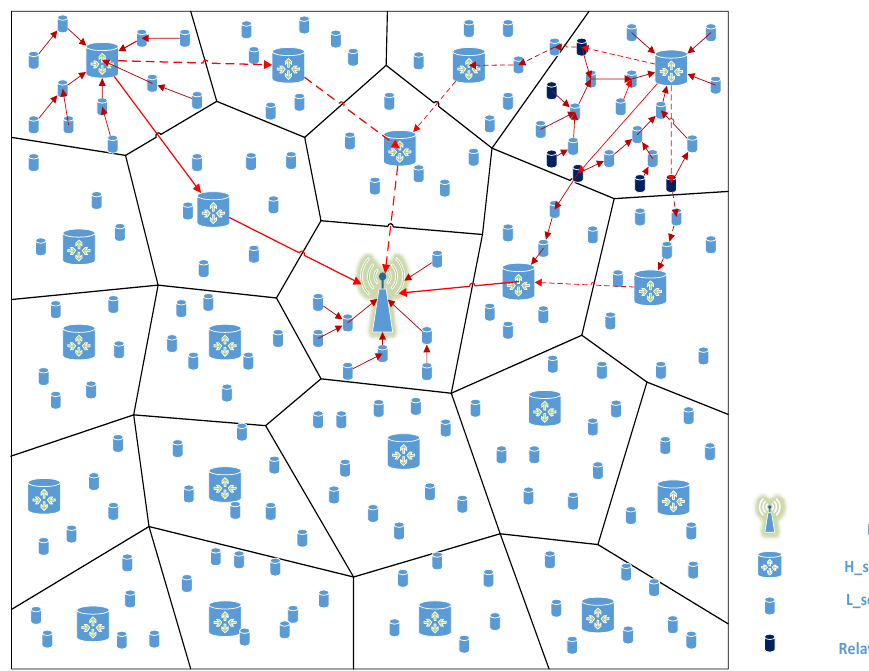
Figure 1. System model.